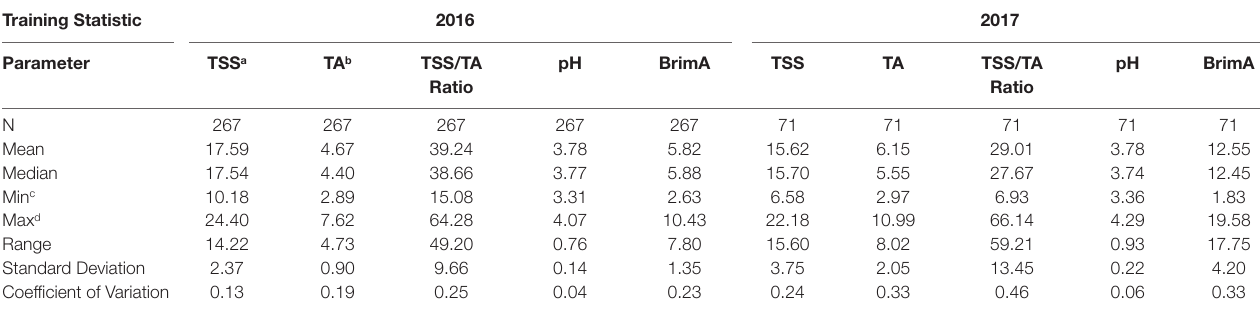
TABle 3 | Statistical analysis of sample sets for the table grape quality parameters TSS, TA, TSS/TA Ratio, pH and BrimA under study collected in the 2016 and 2017 harvesting seasons to incorporate seasonal changes. Training Statistic 2016 Parameter